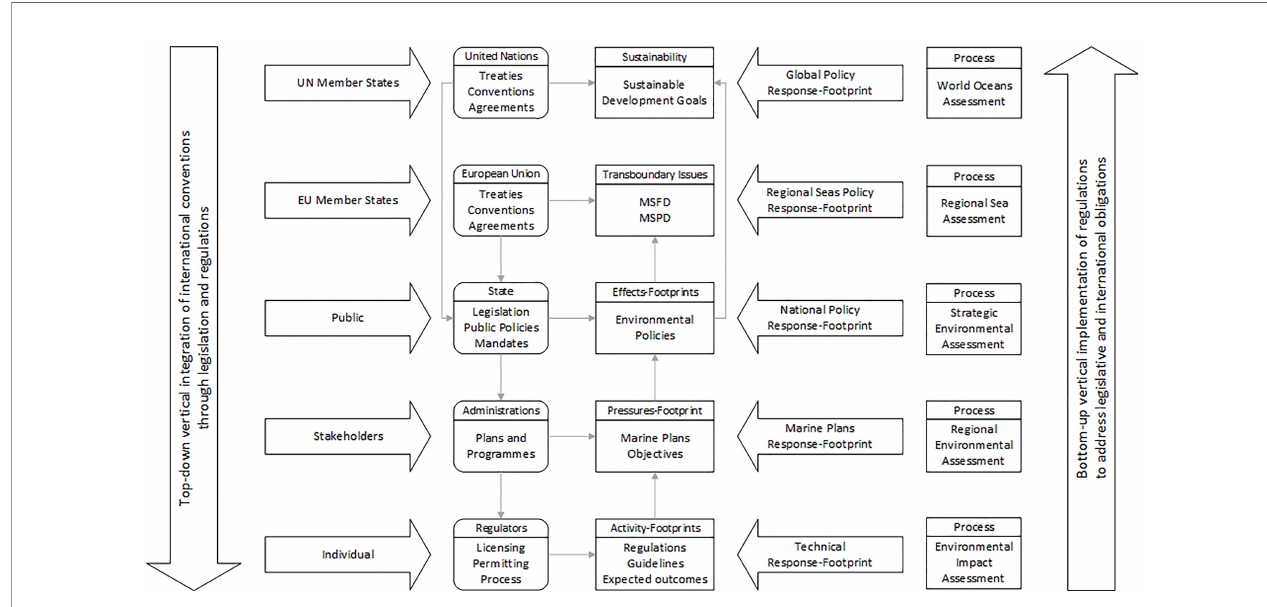
FIGURE 1 | The vertical link between policies, plans and technical response-footprints. Key for examples provided: MSFD, Marine Strategy Framework Directive; MSPD, Maritime Spatial Planning Directive; UN, United Nations; EU, European